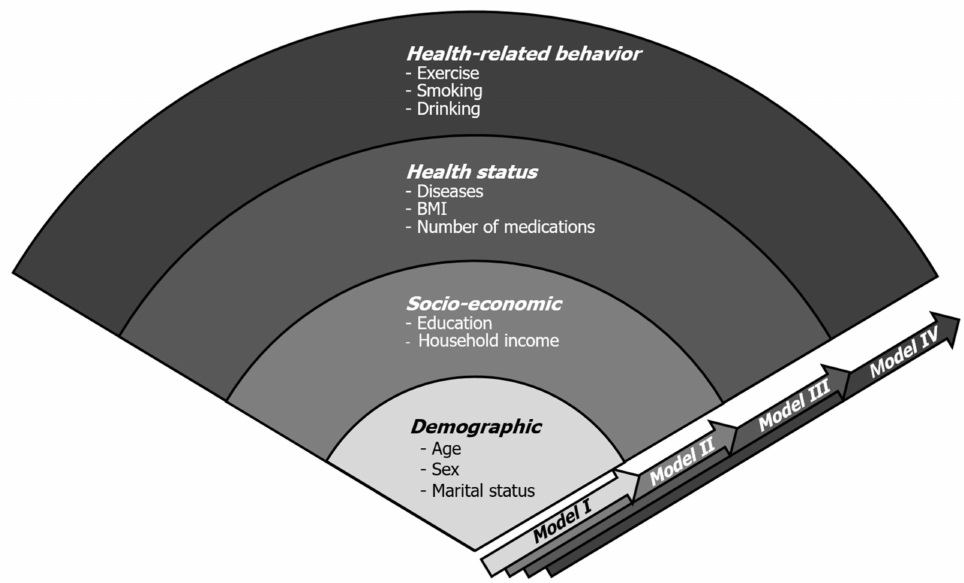
Figure 2. Proposed individual variables-adjusted models. The variables from individual subcate- gories (demographic, socioeconomic, health status, and health-related behavior) were combined in consecutive order and four experimental models were